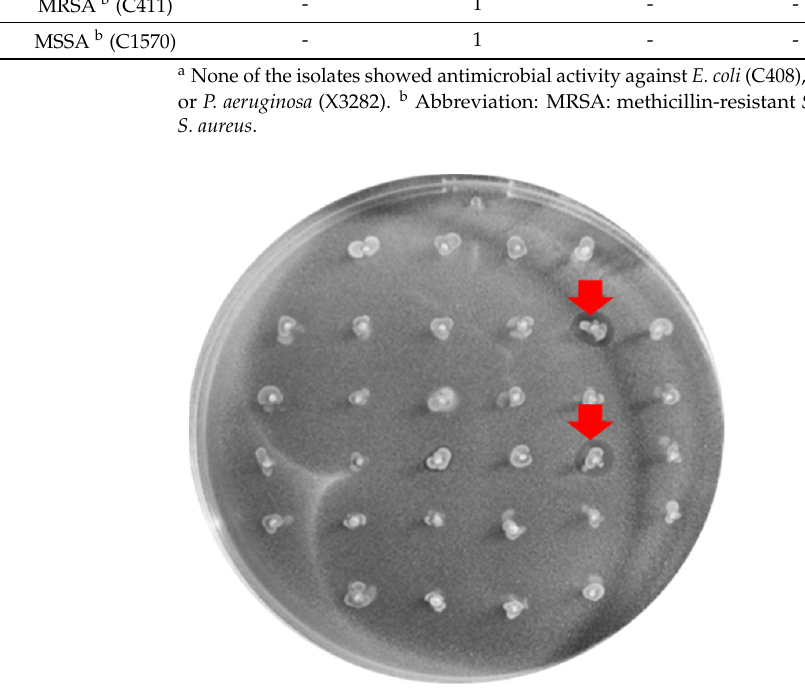
Figure 1. Inhibition halos (marked with the red arrow) produced by 2 of the BP+ enterococci tested against the C. perfringens X2967 indicator strain. Table 1. Antimicrobial activity of the 32 bacteriocin producer (BP+) enterococci against C. perfringens X2967 and other relevant indicator bacteria a , as detected by the “spot on the lawn” assay.